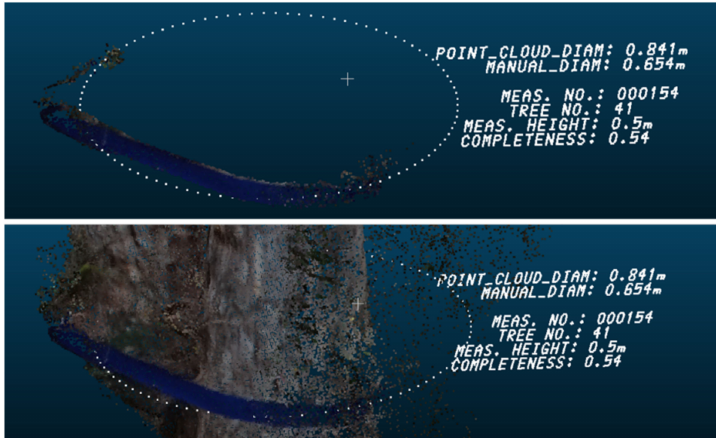
Figure 11. An example of a noncircular stem fitted with a circle. In this situation, the point cloud-based diameter is an overestimate compared to the manually measured reference